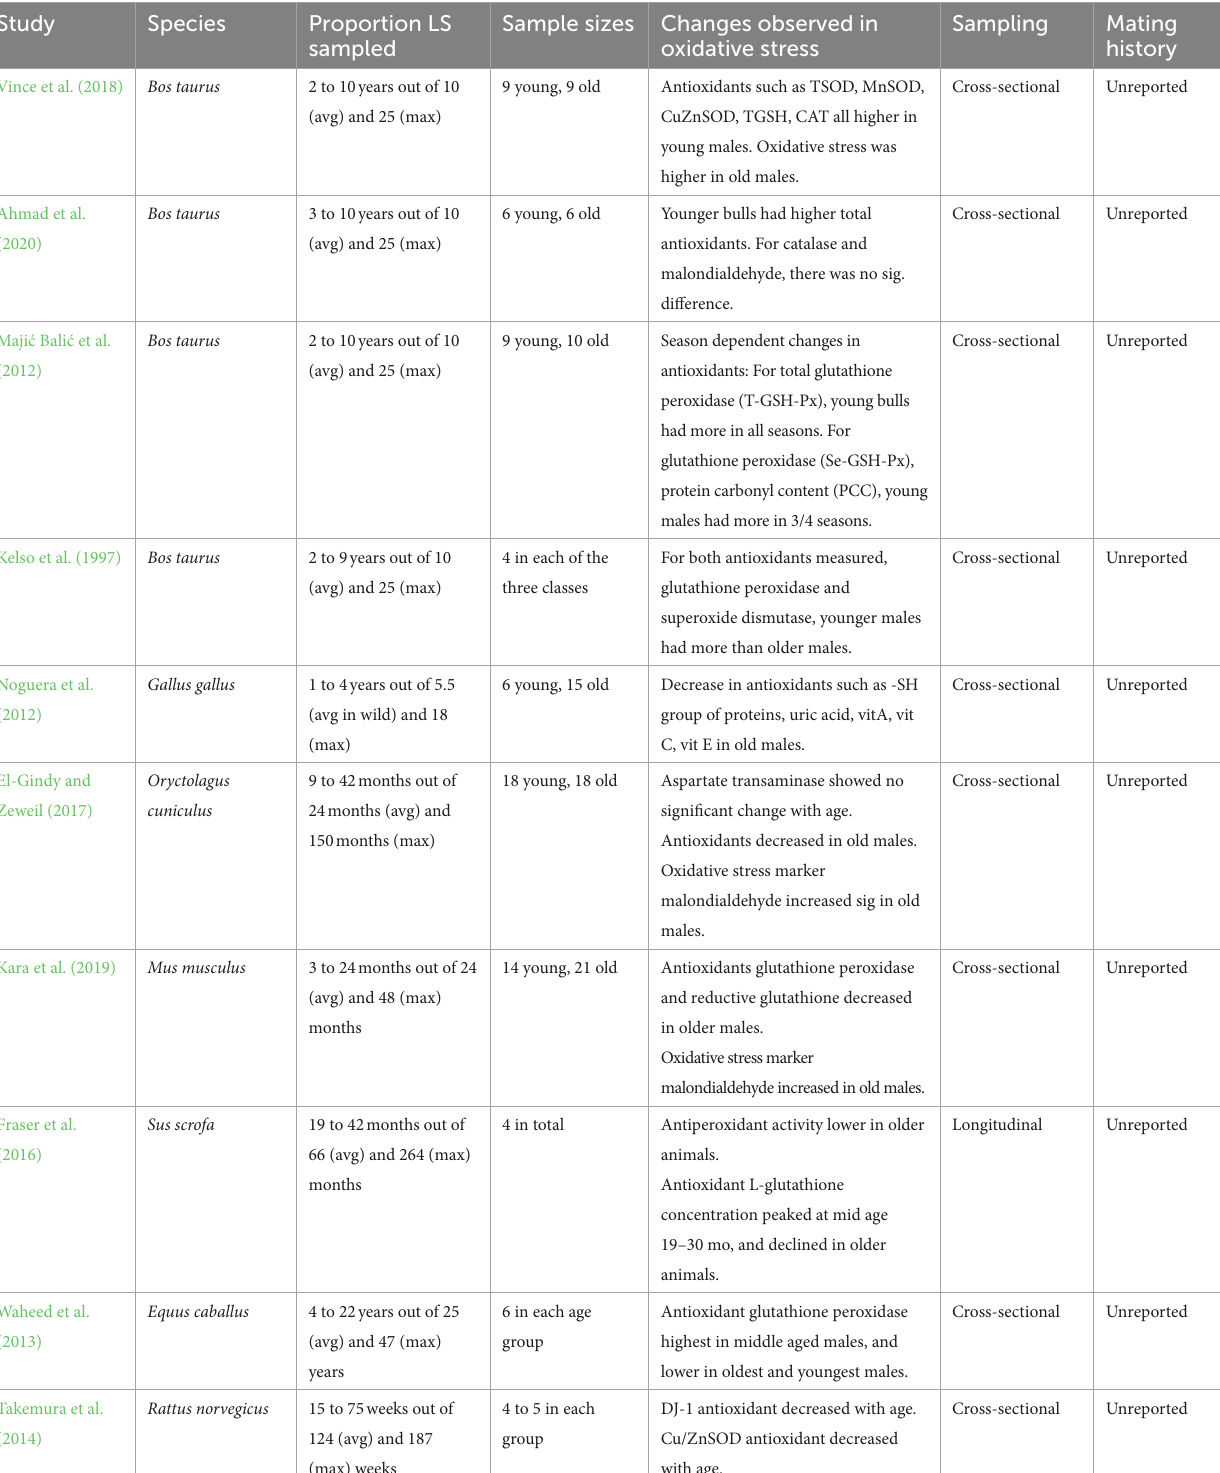
TABLE 2 Summary of studies found in the systematic literature search that focus on male-age dependent changes in antioxidants, oxidative stress biomarkers and reactive oxygen species in male ejaculates/seminal